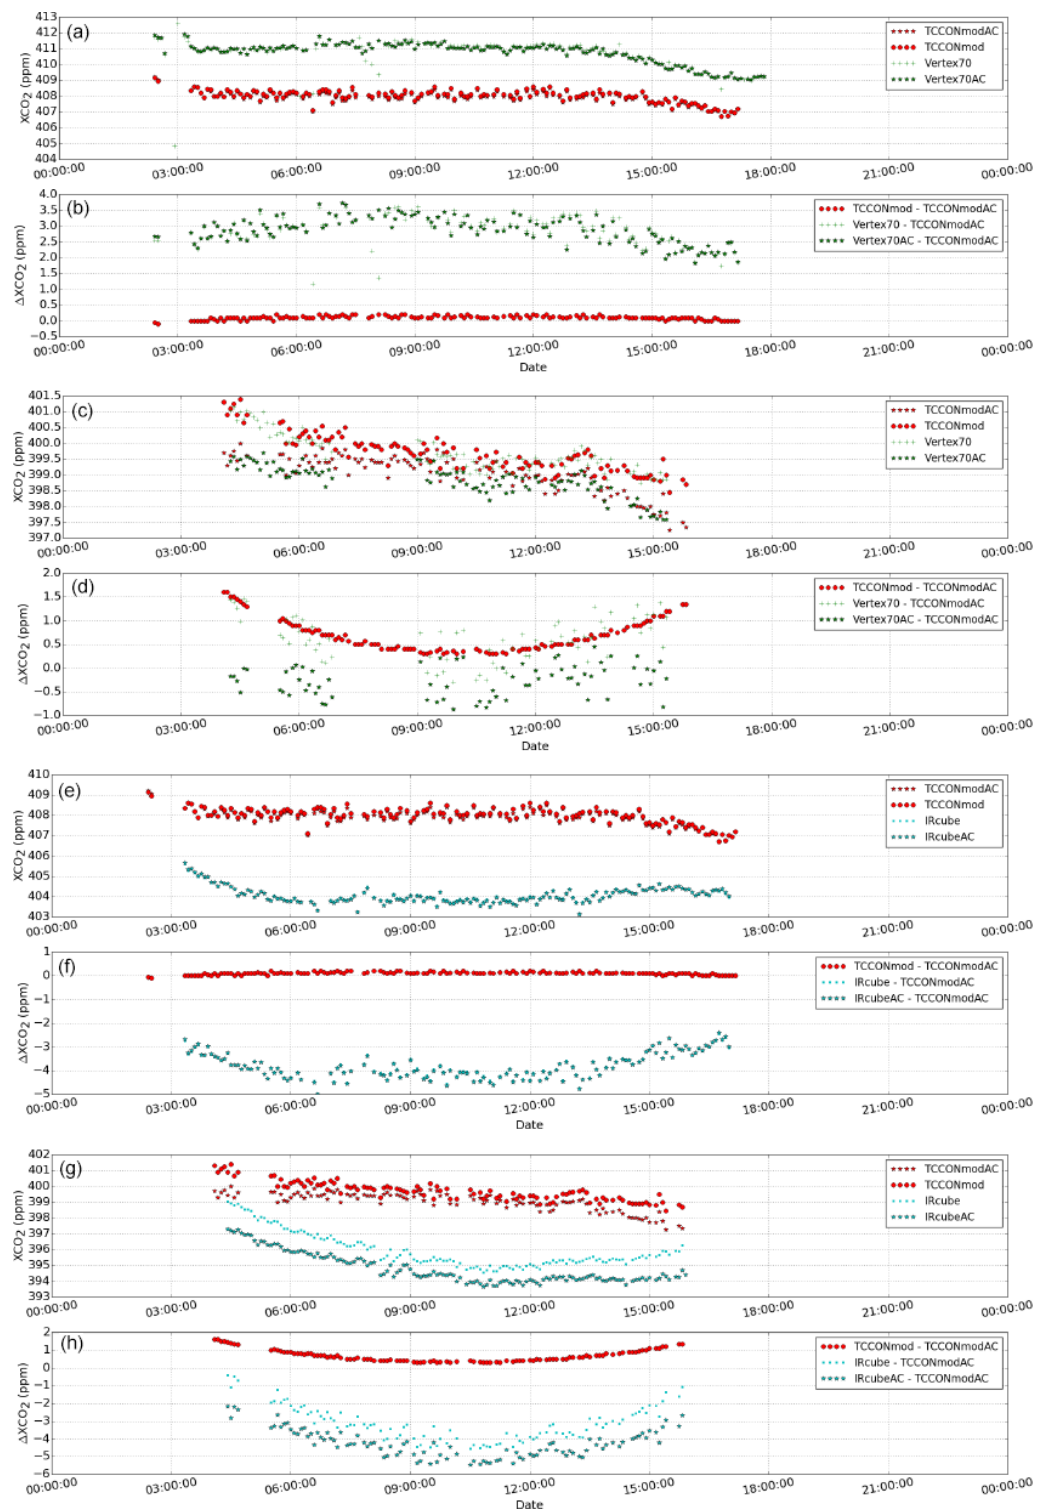
Figure A4. XCO 2 values plotted for TCCONmod and Vertex70 retrievals with the TCCON a priori and with a modified a priori (calculated using in situ, AirCore, and TCCON map files; labelled with AC at the end) are shown in panel (a) , and their difference is shown in panel (b) for measurements performed on 15 May 2017 at Sodankylä. Panels (c) and (d) show the same plots for 28 August 2017. The same plots for TCCONmod and IRcube retrievals for measurements performed on 15 May 2017 are shown in panels (e) and (f) , and those for 28 August 2017 are shown in panels (g) and (h)